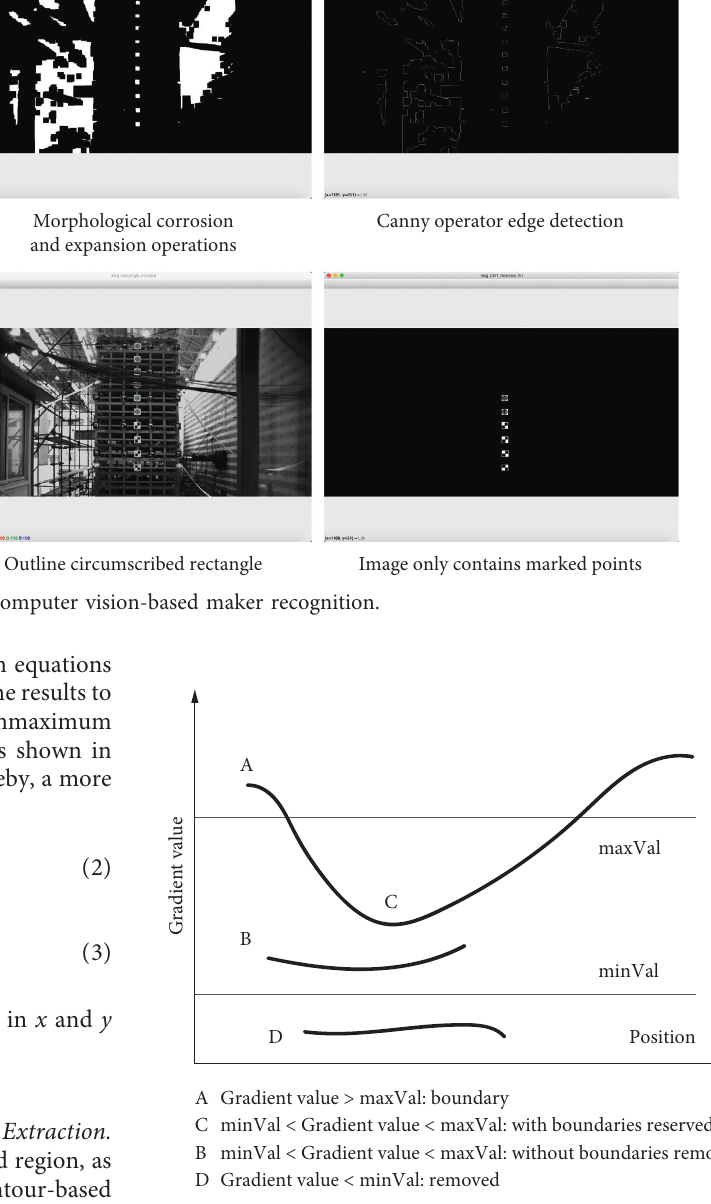
Figure 5: Nonmaximum